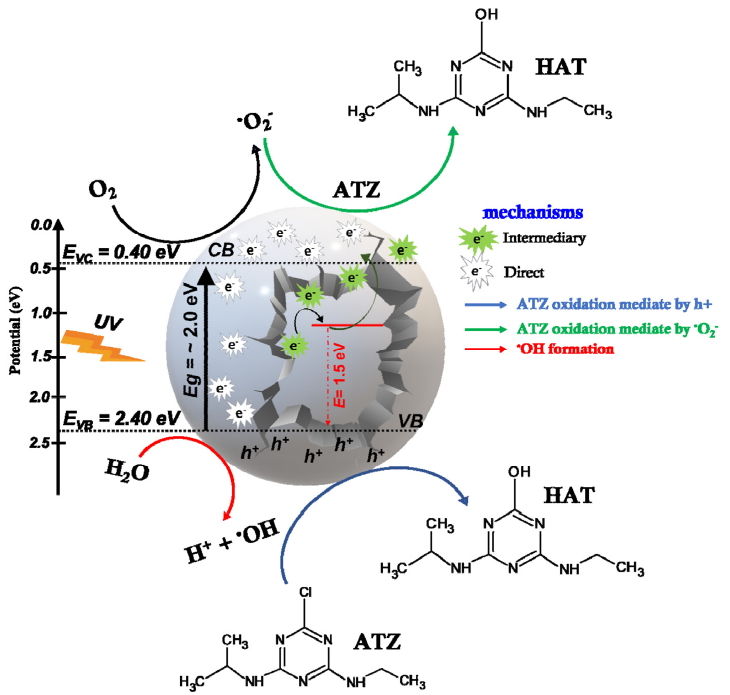
Figure 10. Proposal of a photocatalytic mechanism for the ATZ degradation mediated by Co3O4-4%Ni+rGO SG.